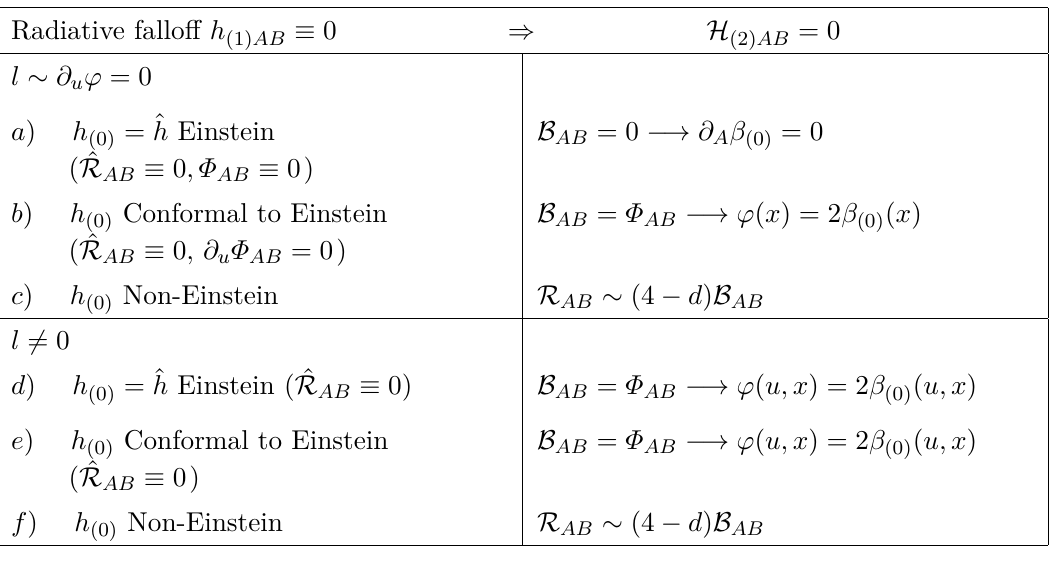
Table 1 . Synoptic view of various constraints imposed on the boundary data ( h request h ≡ 0 in d > 4 . The right column reports the conditions stemming from H (1) AB the assumptions in the left column and the simple arrow −→ indicates a possible solution of the